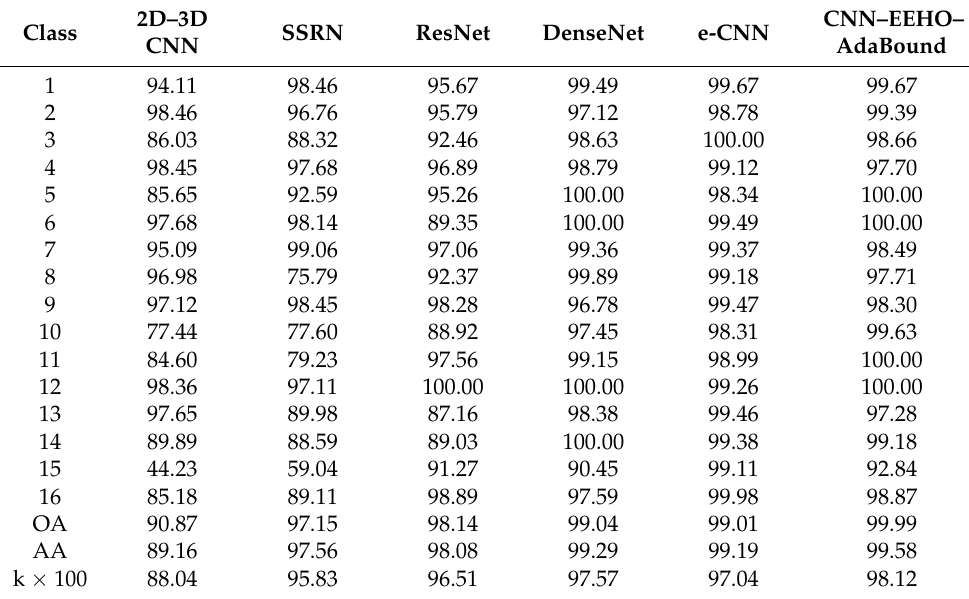
Table 5. Class-wise overall accuracy (OA%), average accuracy (AA%), and k kappa are represented in the Salinas dataset.